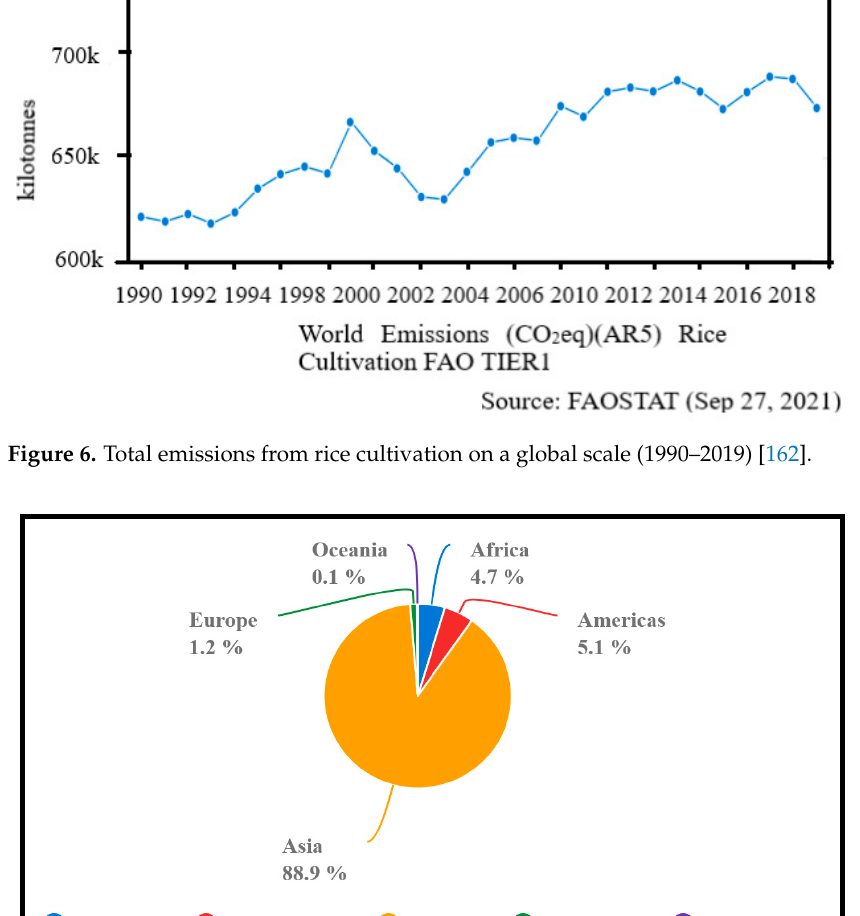
Figure 8. Top 10 emitters (emissions CO 2 eq (AR5)) from rice cultivation (average 1990–2019) [162].